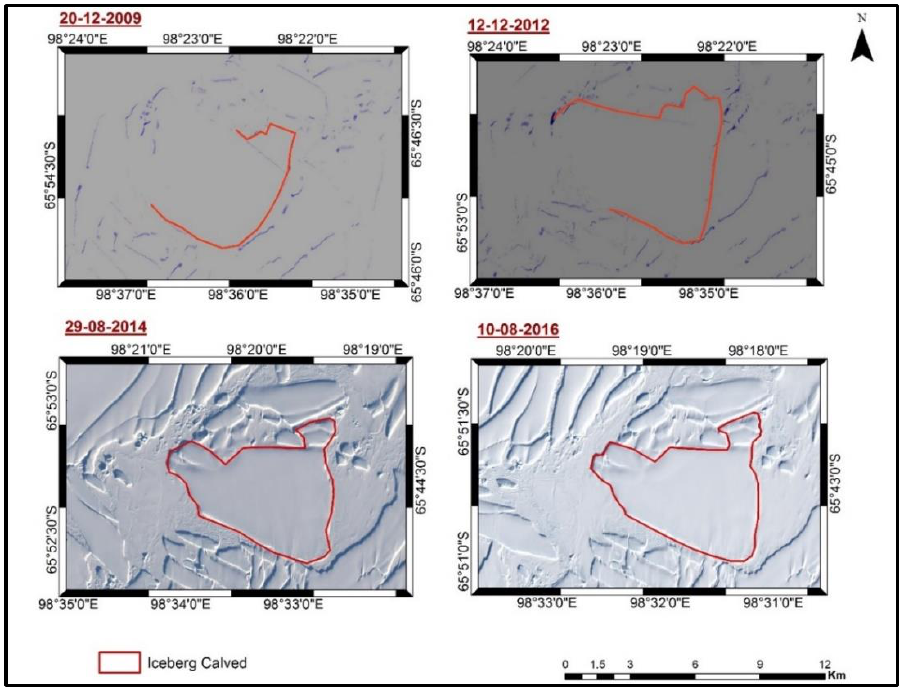
Figure 4. Calving event at Queen Mary coast